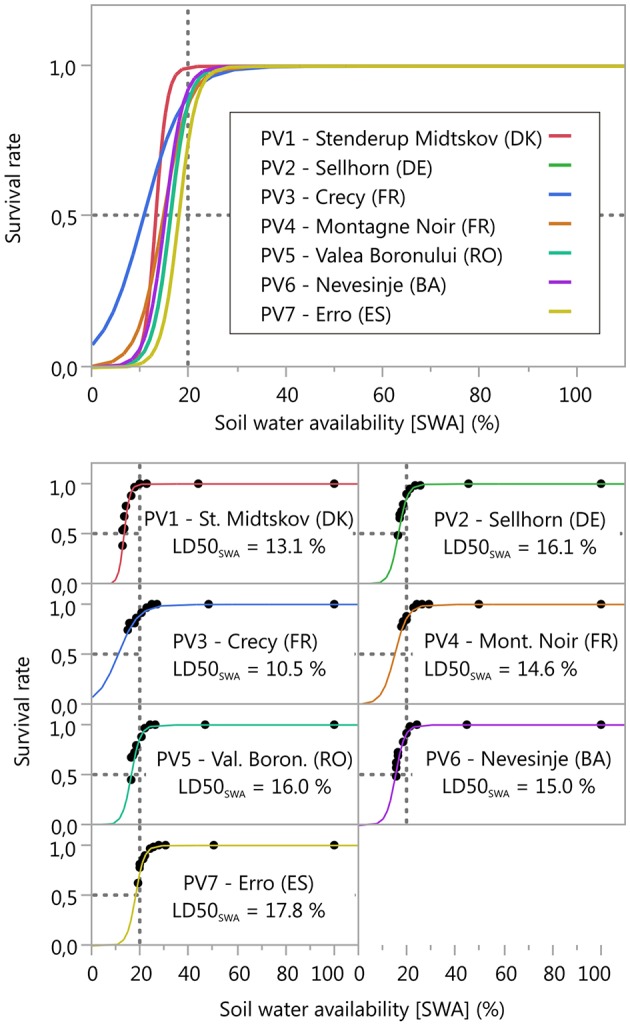
Relationship between soil water availability [SWA] (%) and the survival rate, critical soil water availability (LDSOswA) derived from the 2PL model (50% mortality at the inflection point = LDSOswAI see chapter on analyses). The 20% SWA line found to be a critical threshold for plant performance by other studies (e.g., Granier et al., 2007; Domec et al., 2015) is displayed for orientation. Further information is shown in Table 3.